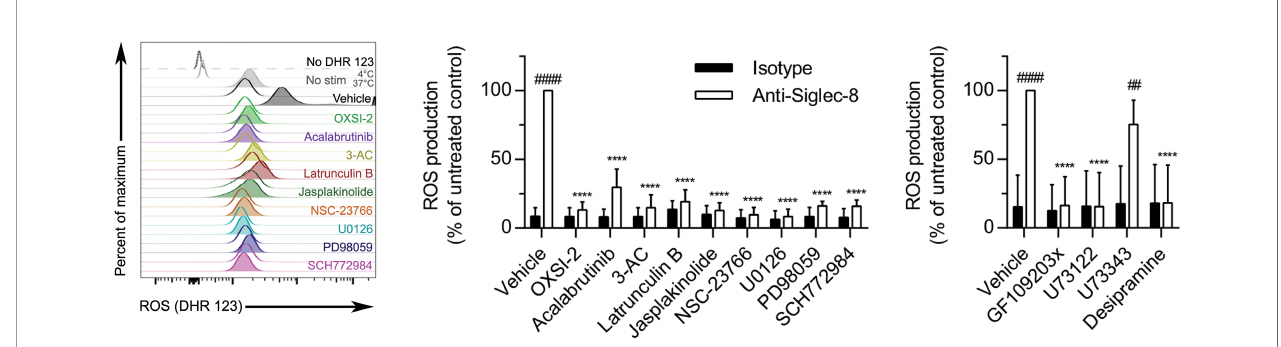
FIGURE 7 | In addition to molecules involved in CD11b surface upregulation and activation, actin polymerization is necessary for Siglec-8 – induced ROS production. Following pretreatment with the indicated agents for 30 min and treatment with anti-Siglec-8 ( fi lled histograms) or isotype control mAb (empty histograms) for 120 min, ROS production was assessed by fl ow cytometry on live (DAPI-negative) eosinophils using DHR 123. Controls include samples lacking the DHR 123 probe, or those with the stain but maintained at 4°C or 37°C without stimulation (No stim). DHR 123 fl uorescence was normalized to that of anti-Siglec-8 mAb – stimulated eosinophils that were not treated with any pharmacological inhibitor. Data represent means ± standard deviations of 3 independent experiments. ****p < 0.0001 relative to within – antibody stimulation group vehicle control sample. ## p < 0.01, #### p < 0.0001 relative to within – pretreatment group isotype control